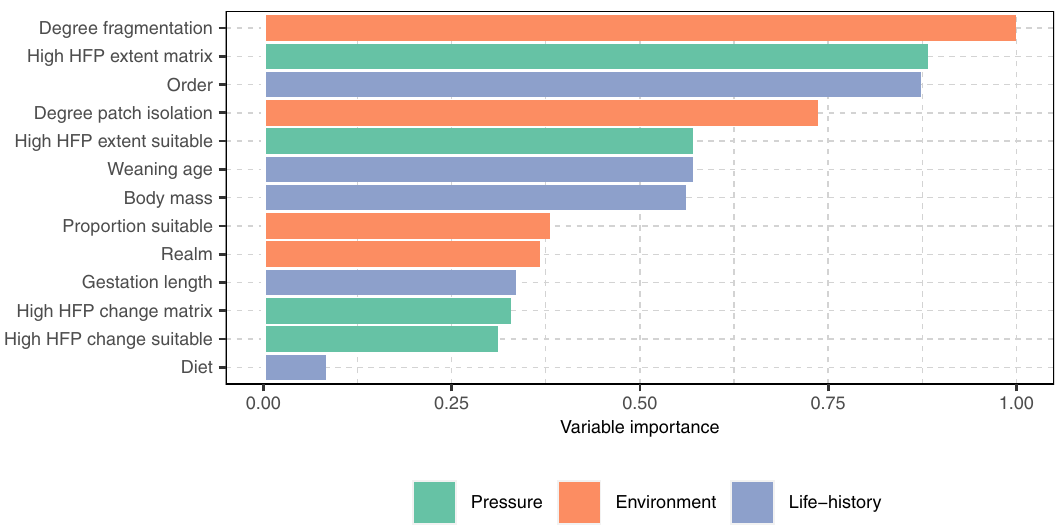
Fig. 2 Relative importance of selected variables for the prediction of extinction risk transitions in terrestrial mammals. Variables are colour-coded according to their broad class (human pressure, environment and life history). The description of each variable can be found in Table 1. High levels of the human footprint (HFP) included values of 3 or above. Source data are provided as a Source Data fi le.